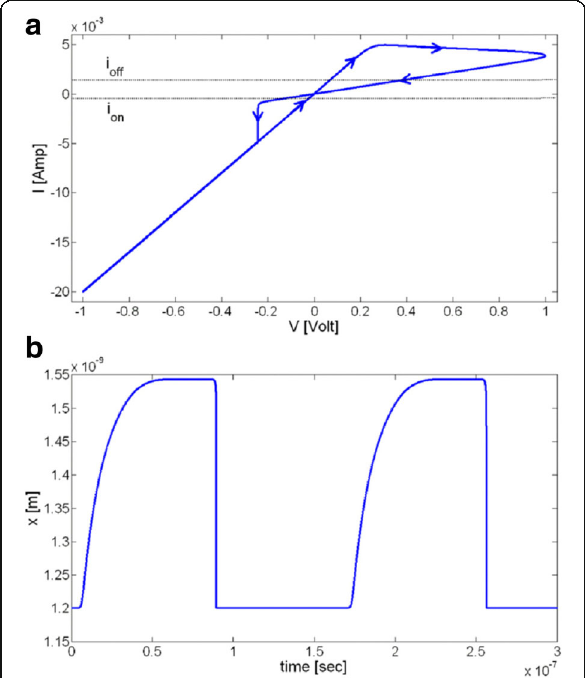
Fig. 8 A sinusoidal input of 1 V applied to the TEAM model using the same fitting parameters as used in Fig. 10 [76]. The values of R ON and R OFF are set as 50 Ω and 1 k Ω , and an ideal rectangular window function is applied in Eqs. (38) and (37). a I - V curve and b state variable. It is to be noted that the device is asymmetric, i.e., switching OFF is slower than switching ON